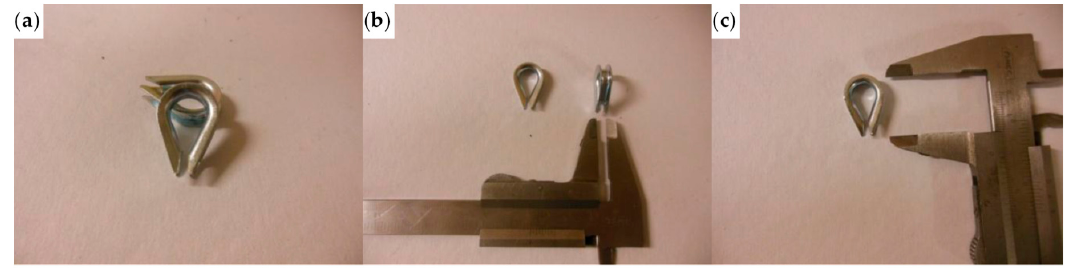
Figure 32. The thimbles of the experimentation: ( a ) overview; ( b ) thickness; and ( c ) longitudinal dimension.